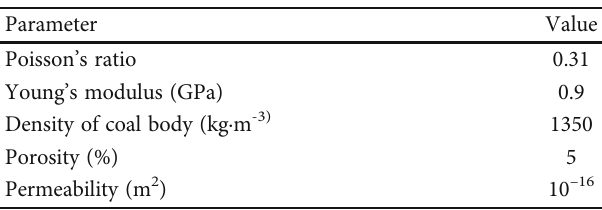
Figure 4: Geometric model ( P is the burst pressure). Table 1: Basic parameters of the